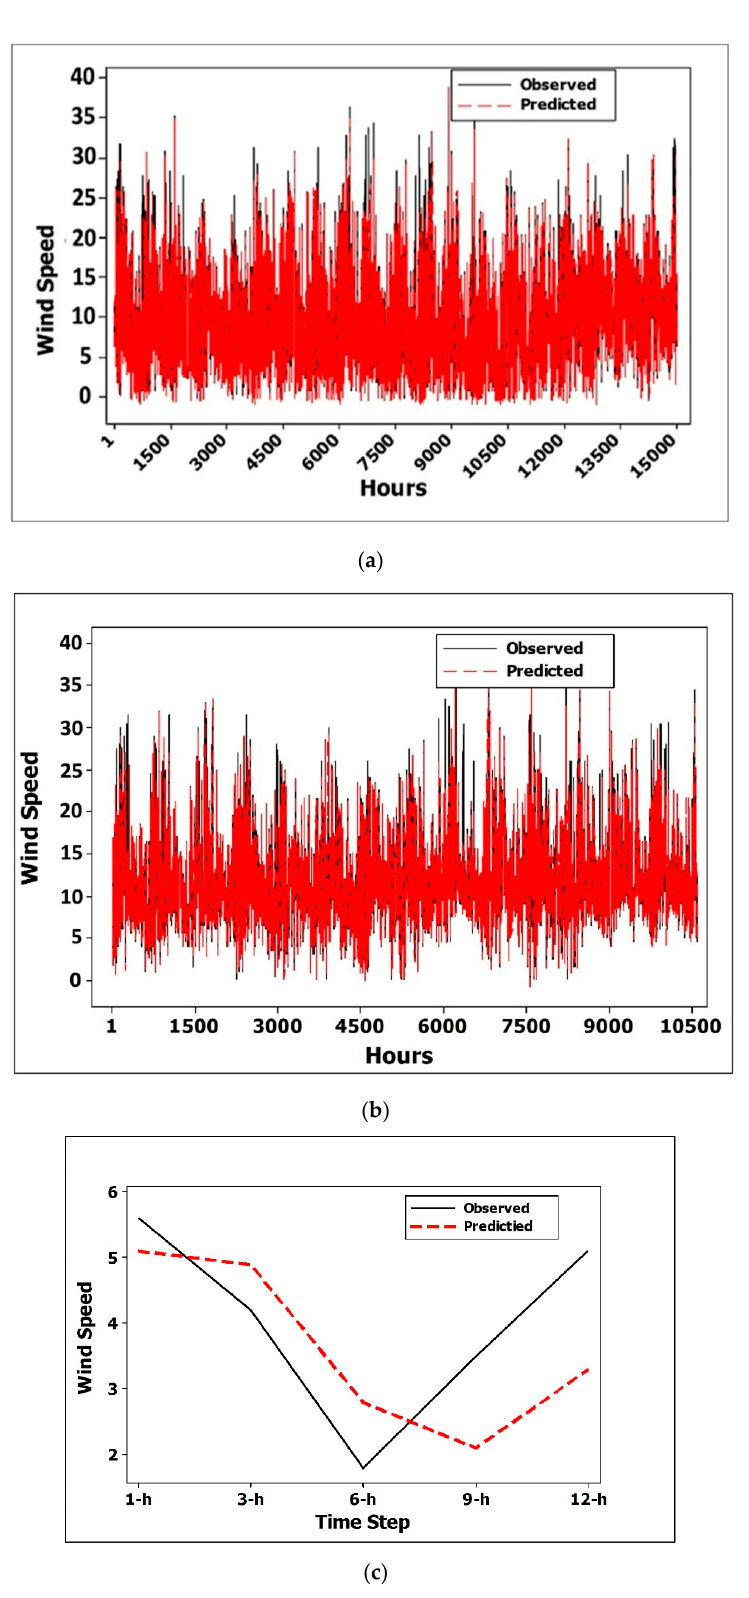
Figure 8. Wind speed (km/h) forecasting analysis of IT2F-LSTM (81-15-1) during the ( a ) training, ( b ) testing, and ( c ) predicting periods.